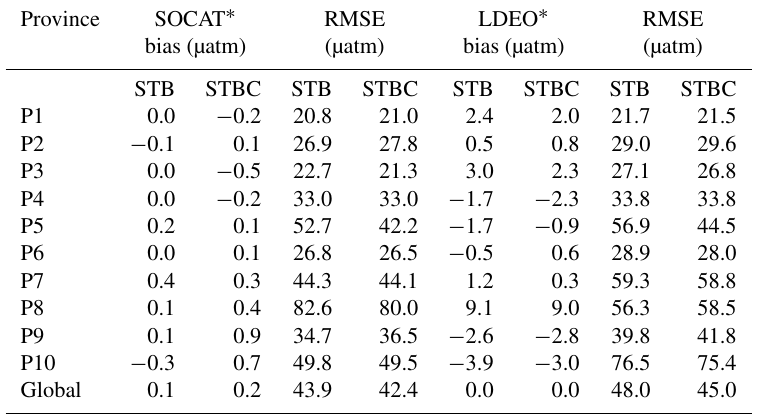
Table 4. Biases and root mean square error (RMSE) between observed and calculated p CO 2 using only SST, SSS and bathymetry (STB) or SST, SSS, bathymetry and chlorophyll (STBC) as